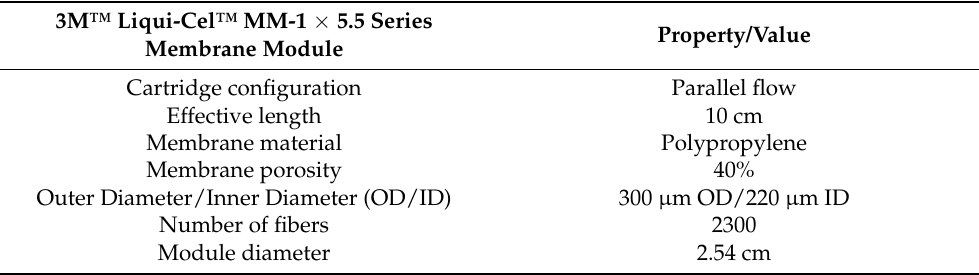
Table 1. Membrane module characteristics [31].